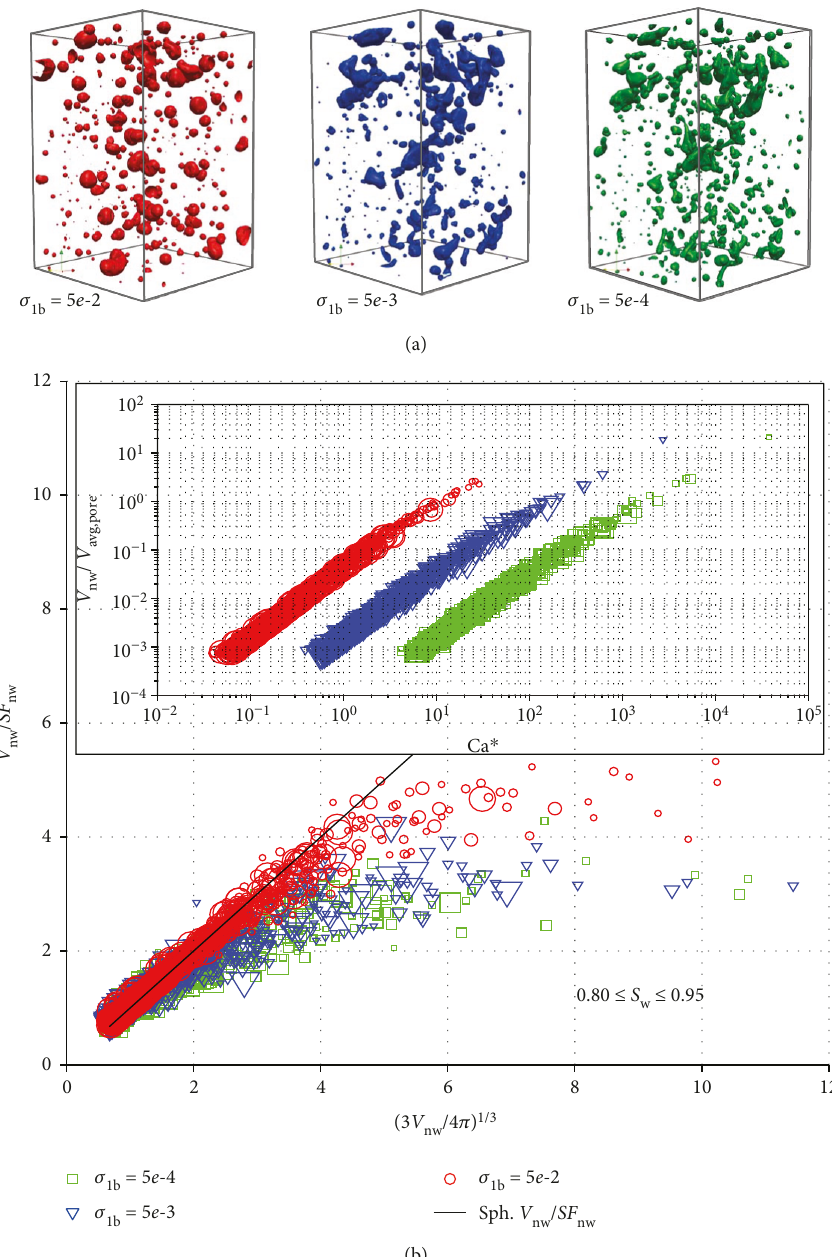
= 5 × 10 − 2 , 5 × 10 − 3 , and 5 × 10 − 4 ) lb